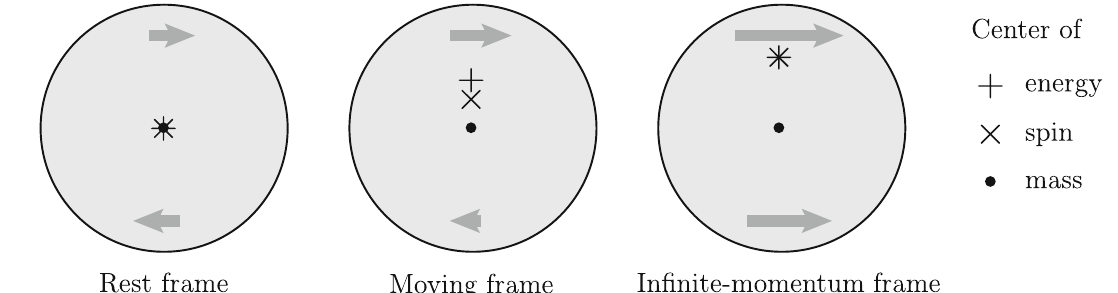
Fig. 1 Illustration of the relative positions of the relativistic centers of energy, mass and spin given in Table 1 inside a transversely polarized nucleon. The spin vector points into the figure and the nucleon has non vanishing momentum towards the right in the second and third pan- els. Angular momentum in the Belinfante form being purely orbital, the nucleon can be pictured as a rotating non-rigid body. The arrows